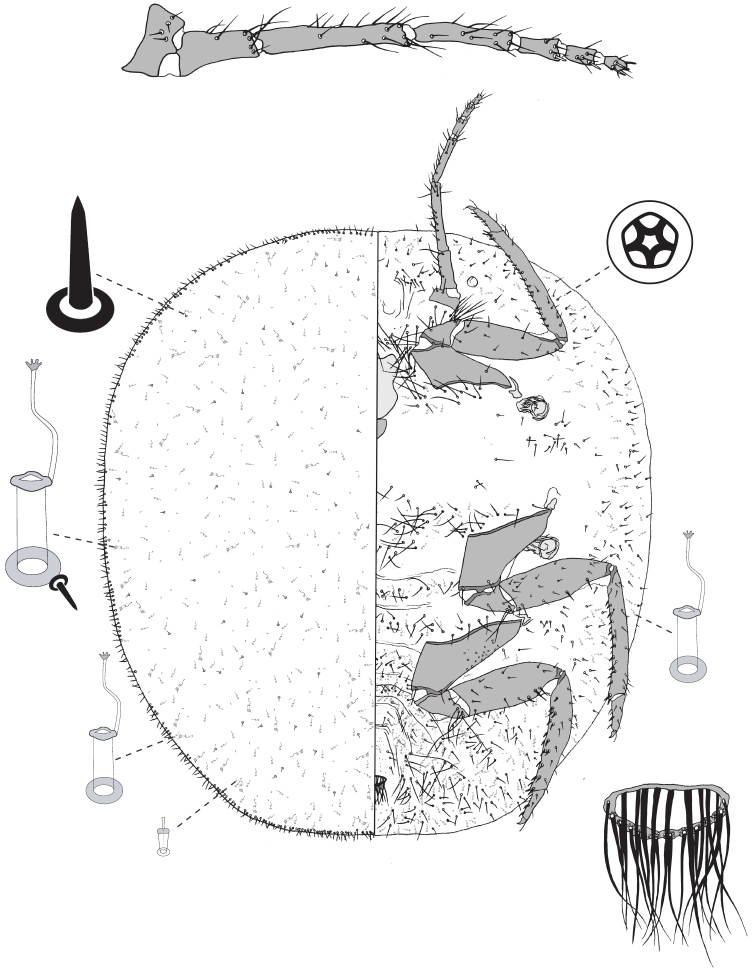
Adult female of Lachnodiusfroggatti sp. n.